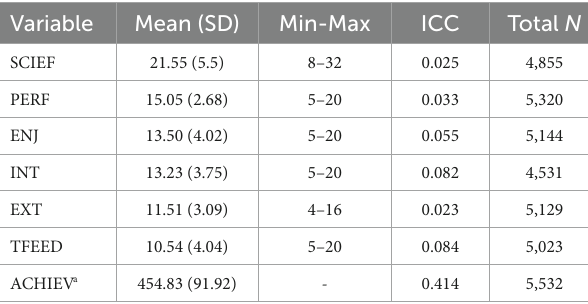
TABLE 2 Descriptive statistics for key